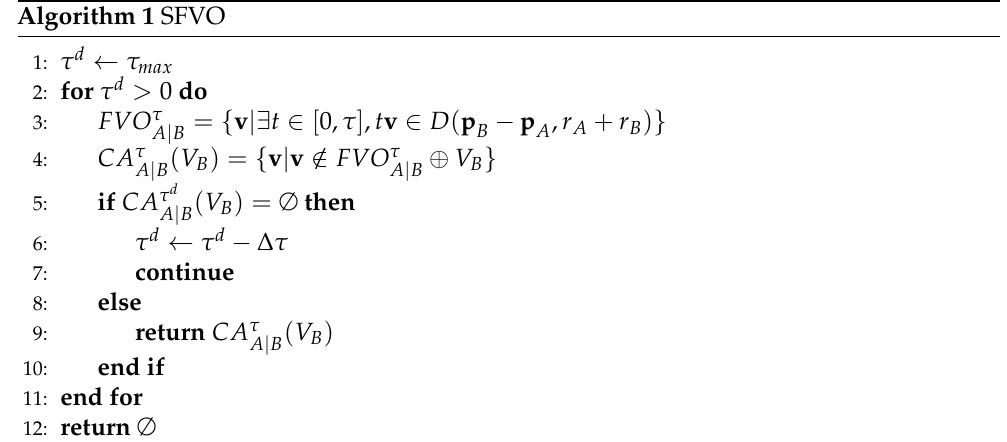
Figure 5. FVO algorithm diagram. In the left figure, the shaded area shows the relative velocity that will cause collision in time in the future. The right figure shows the collision velocity (shaded area) and collision-avoidance velocity (white area) of the agent given the velocity of the